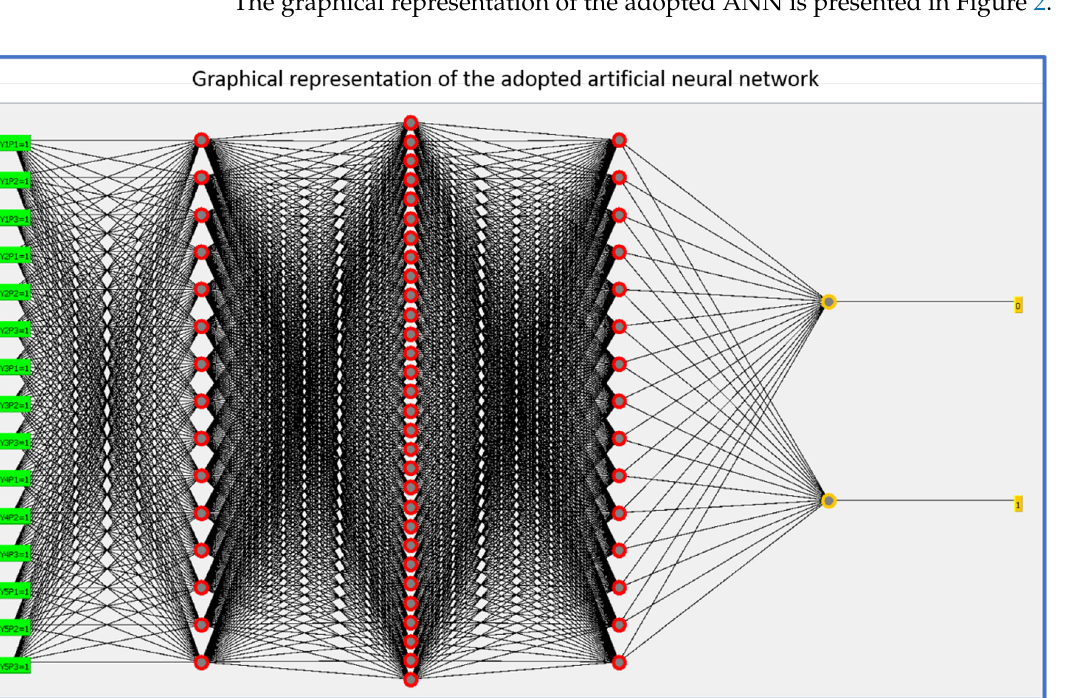
Figure 2. Graphical representation of the adopted Artificial Neural